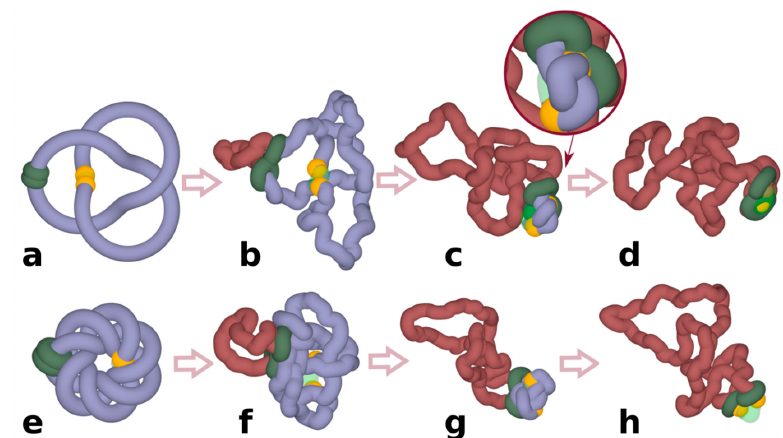
Figure 1. Chromatin loop extrusion unknots individual loop-forming TADs modelled as chromatin rings. ( a – d ) Unknotting of a simple trefoil knot. ( e – h ) Unknotting of a complex knot with 14 crossings. ( c , d ) show highly compressed knots being pushed towards a region with reduced excluded volume potential, which in our simulations mimic the action of Top2B, known to be present near TADs borders. Inset in ( c ) shows a close-up of a strongly confined knot, which is about to get unknotted by an intersegmental passage involving a region with reduced excluded volume potential. ( d , h ) show that at the end of simulations the knots are already unknotted. In our simulations, cohesin rings (green) are initially arbitrarily placed opposite to borders of modelled TADs. Once simulations are started, stacked rings of cohesin take the form of a quasi-planar handcuff and actively translocate in that form. Borders of TADs are recognizable here by yellow coloured beads that in our simulations stop the progression of cohesin rings and thus mimic the biological action of CTCF proteins located at borders of TADs. TAD: topologically associating domain.